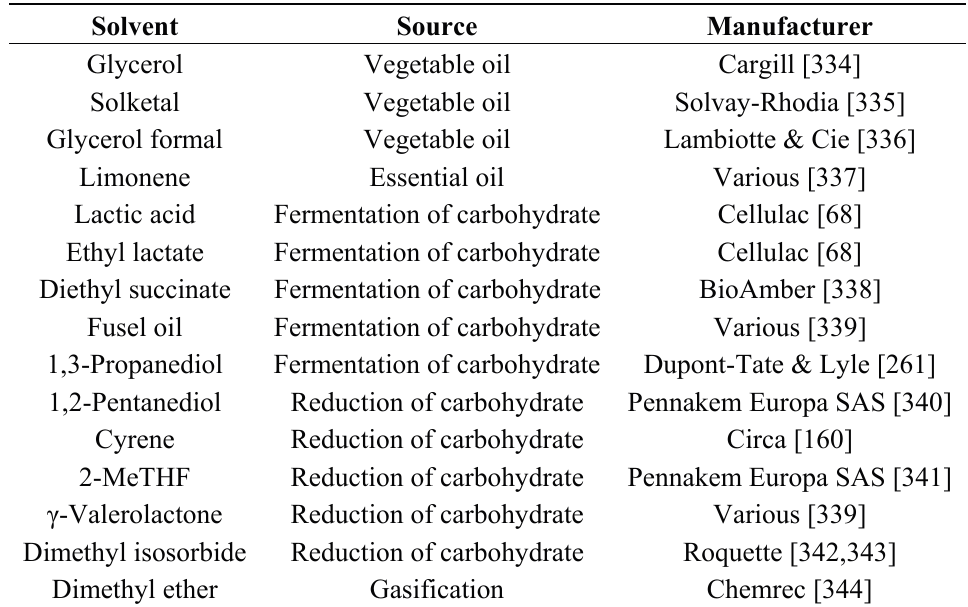
Table 4. A selection of neoteric bio-based solvents that are either commercially available or produced in demonstrator